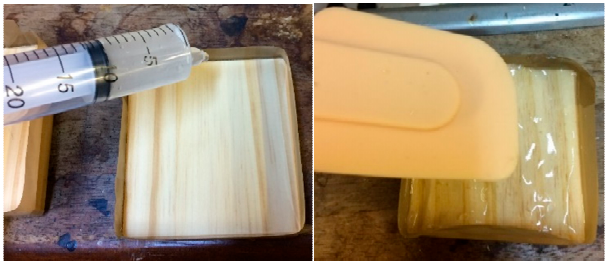
Figure 1. The application of starch ‐ based coatings onto the surface of Taeda pine wood